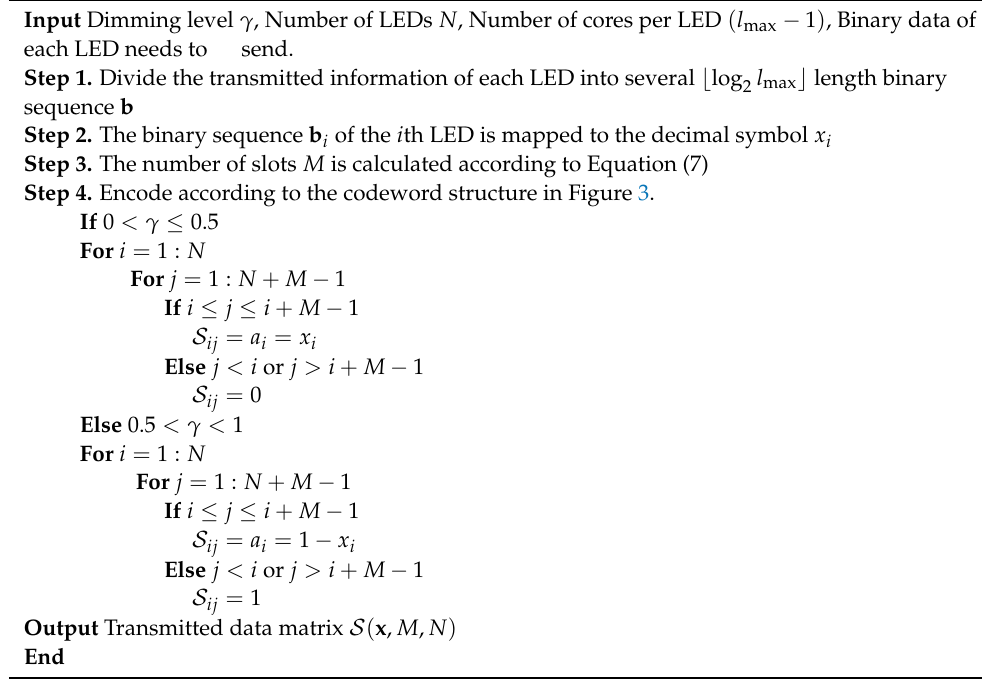
Algorithm 1: Encoding Algorithm of the ML-MTSC